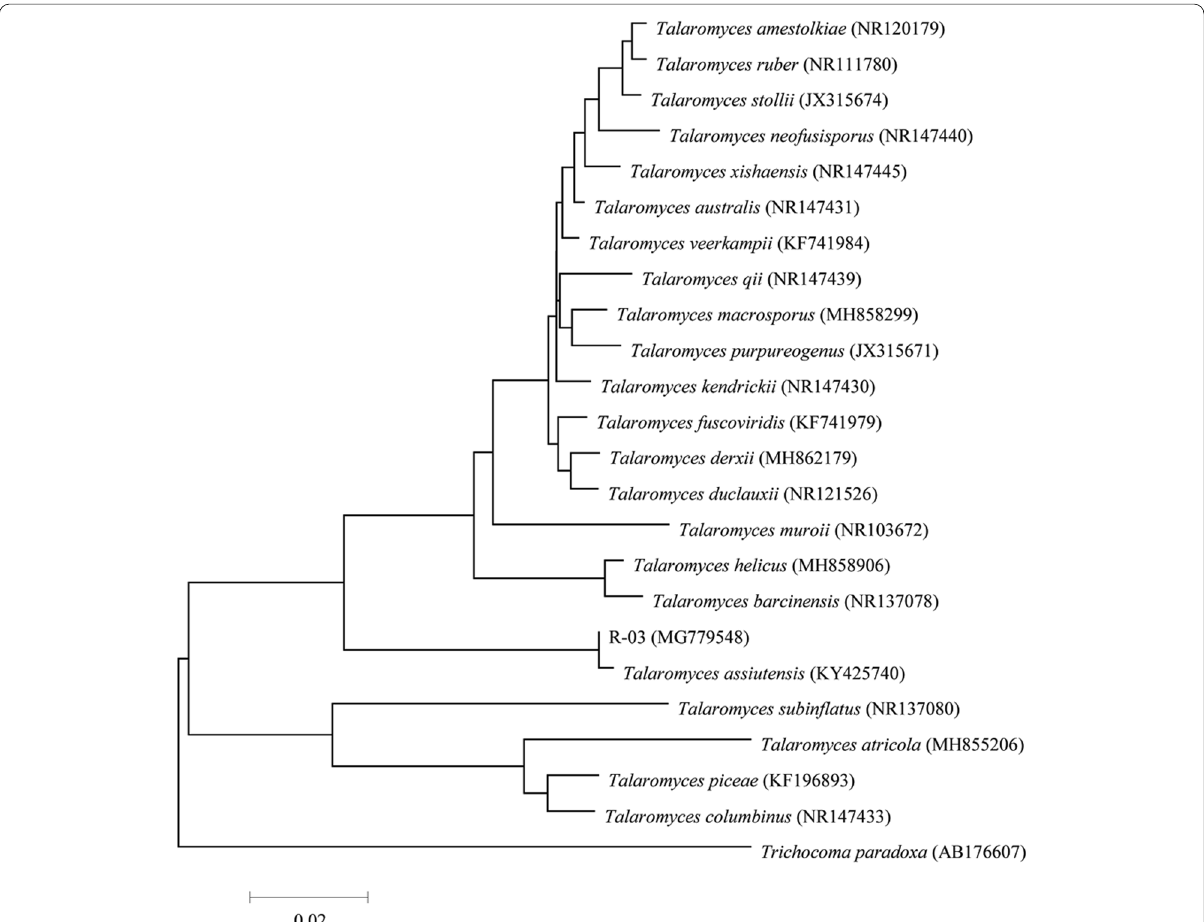
Fig. 4 The phylogenetic tree of Talaromyces assiutensis strain R-03 based on ITS sequence. The contents in parentheses represent the accession numbers in